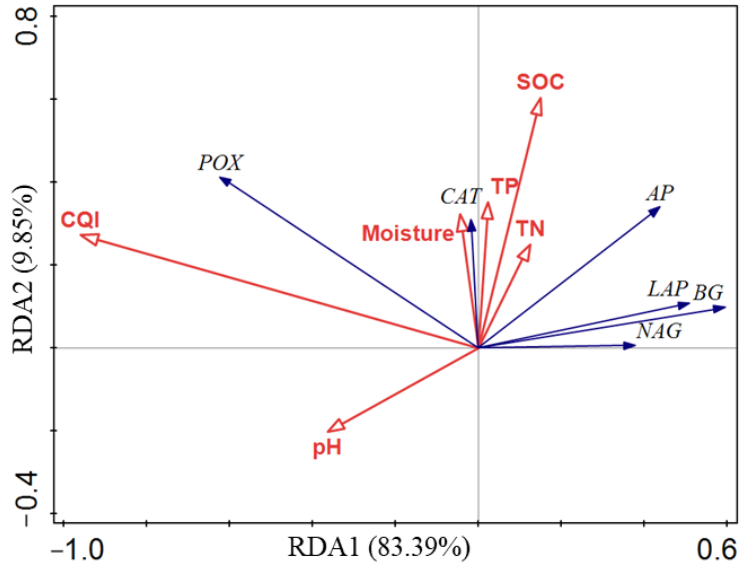
Figure 5. RDA analysis of environmental factors and soil enzyme activity in Wuzhishan National Nature Reserve. The blue arrows represent the six soil enzymes. The red arrows represent the soil physicochemical property indicators and CQI.